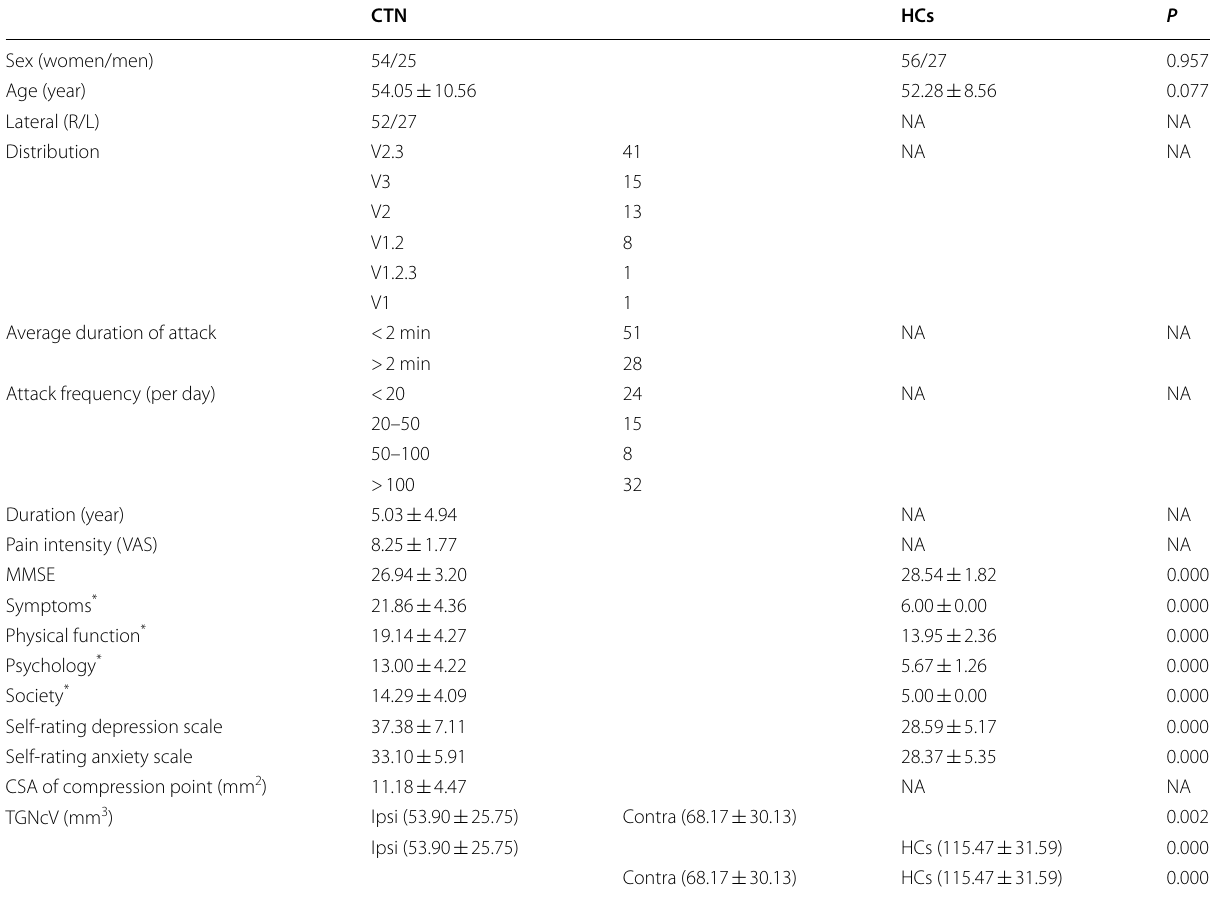
Table 1 Demographic and clinical characteristics of patients with CTN and healthy controls